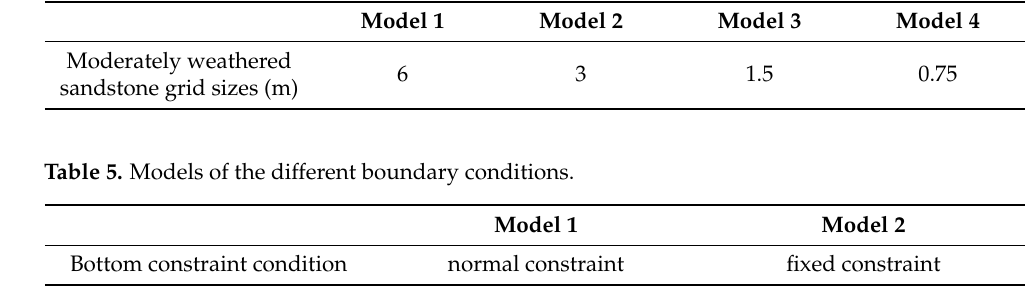
Table 4. Models of different moderately weathered sandstone grid sizes.